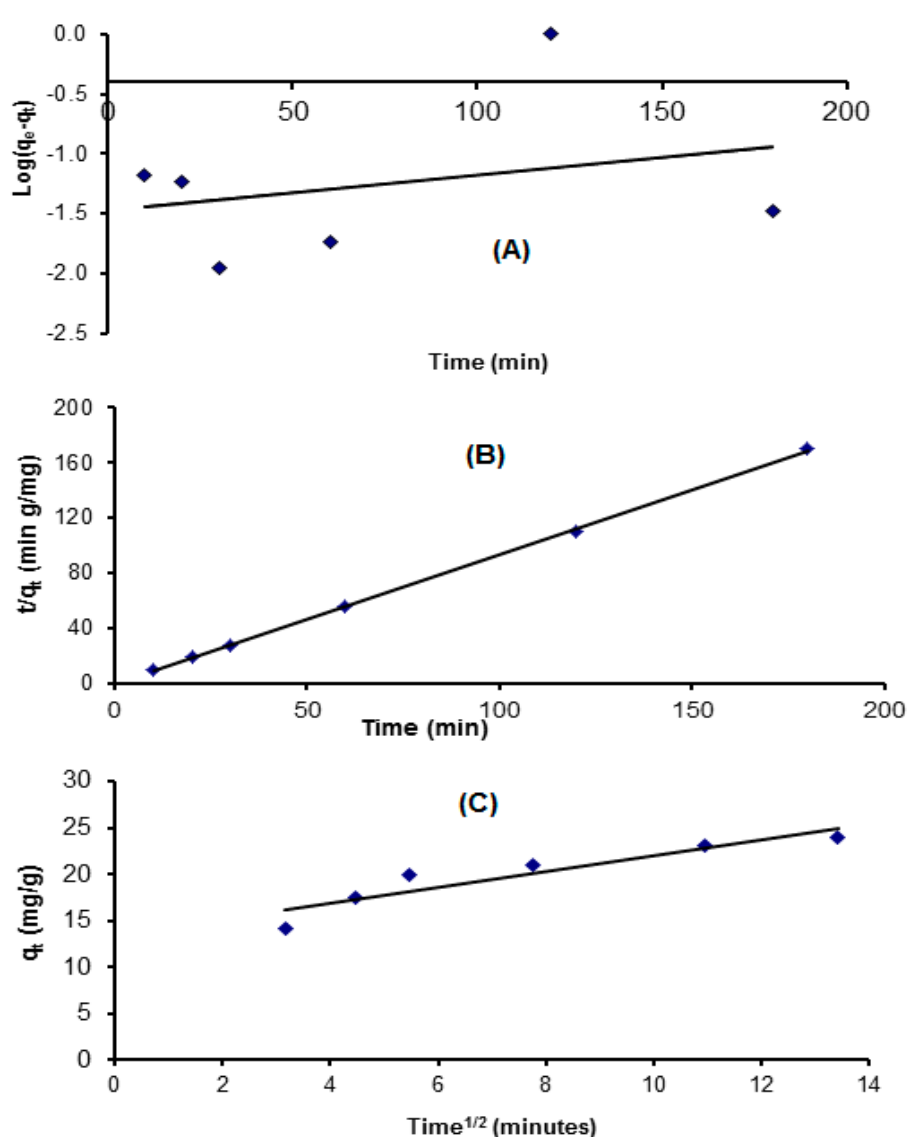
Figure 18. Adsorption kinetics of the pseudo-first-order ( A ), pseudo-second-order ( B ), and intraparticle diffusion equation ( C ) of IV2R adsorption.